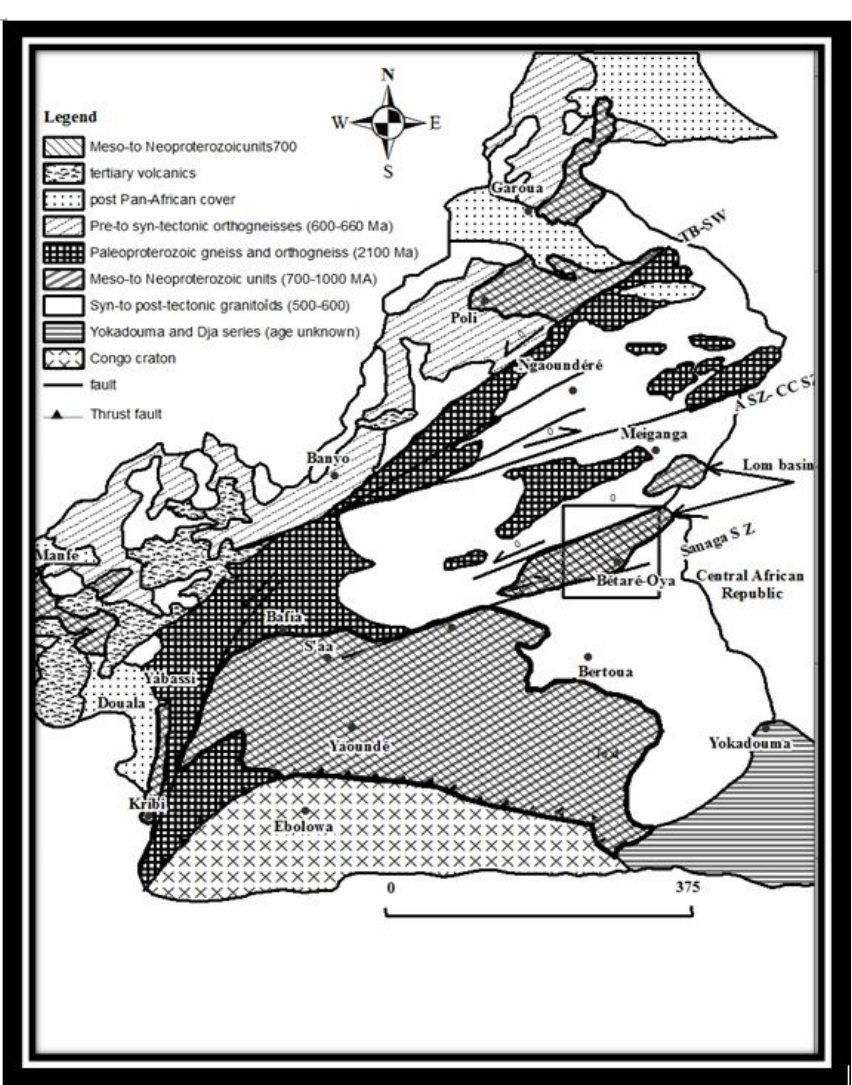
Figure 1. Geologic map of Cameroon, modified from Kankeu et al. (2009) and available in the public domain, showing major lithotectonic units: ASZ, Adamaoua shear zone; CCSZ, central Cameroon shear zone; TBSZ, Tcholliré-Banyo shear zone. The location of the study area is marked by a box and shown in detail in Fig.